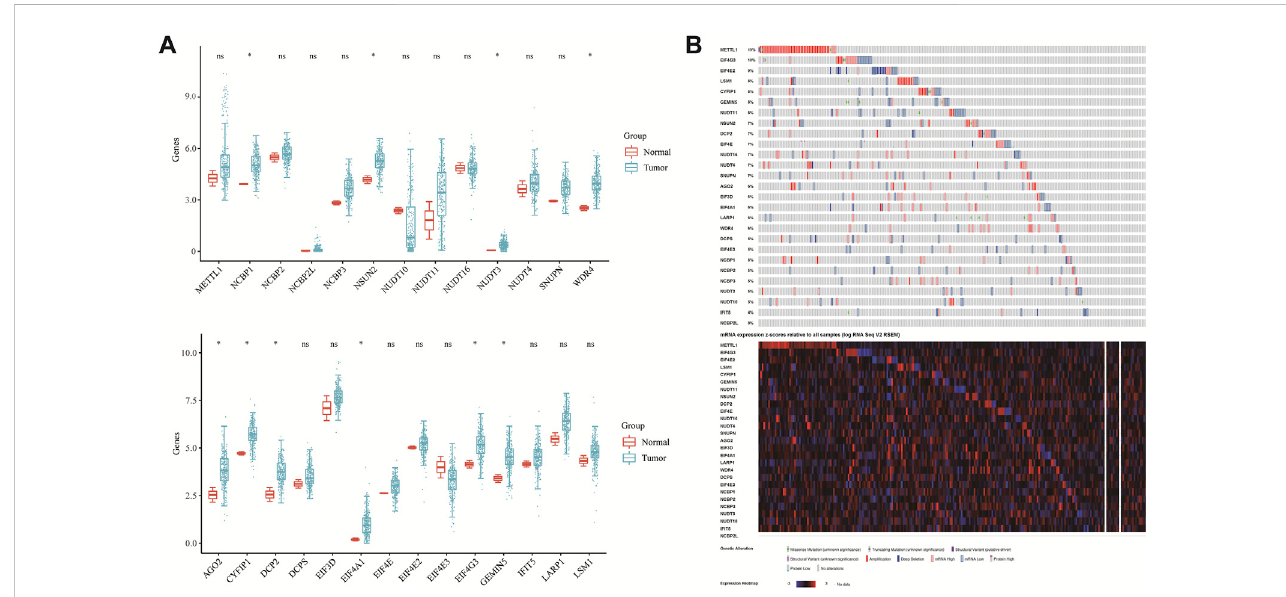
FIGURE 2 The variation and prognostic value of m7GRGs in sarcomas. (A) The expression of twenty-seven m7GRGs in sarcomas and paracancerous tissues. The upper and lower ends of the box represent the quartile range of values; the lines in the box represent the median; (B) the copy number of twenty-seven m7GRGs in the TCGA-SARC